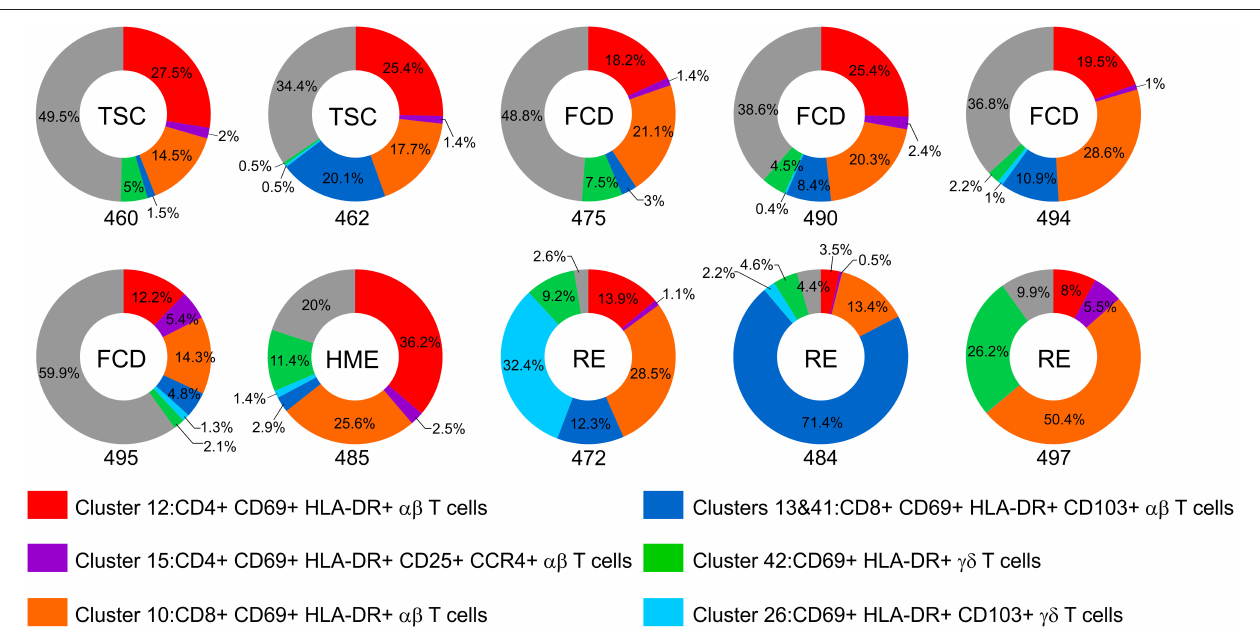
FIGURE 6 | The proportion of activated T cells in the BIL fractions. Donut plots show the relative number of CD69 + HLA-DR + CD4, CD8, and γδ T cells as percentage of the CD3 + cells in each BIL fraction. Each chart corresponds to one of the surgery cases, and are arranged according to the clinical diagnosis (TSC: 460, 462; FCD: 475, 490, 494, 495; HME: 485; RE: 472, 484, 497). The different activated subsets are color coded; the gray area denotes the percentage of T cells that did not express activation markers.